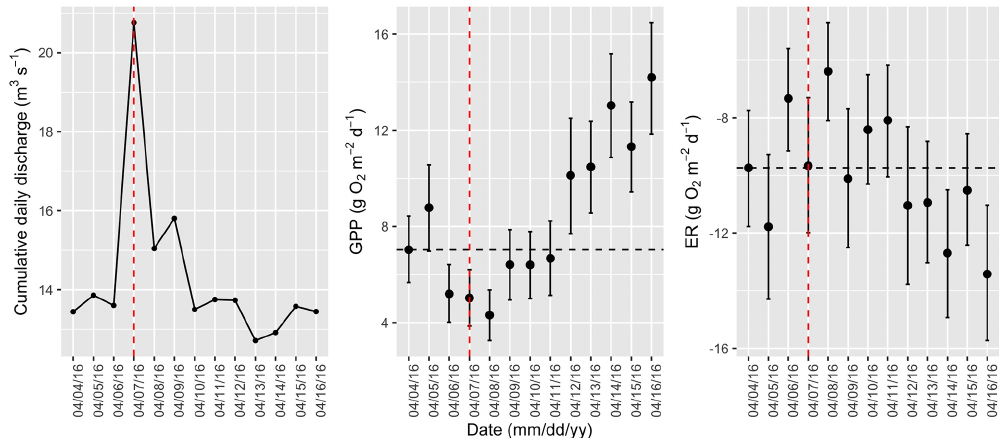
Figure A12. Cumulative daily discharge and metabolism (gross primary production and ecosystem respiration; GPP and ER) time series for the Stroubles Creek flow event on 7 April 2016 (noted with a dashed vertical red line in all three panels). The dashed horizontal black lines are mean values of GPP and ER prior to the high flow event. Error bars for posterior estimates of GPP and ER are 2.5% and 97.5% Bayesian credible intervals.